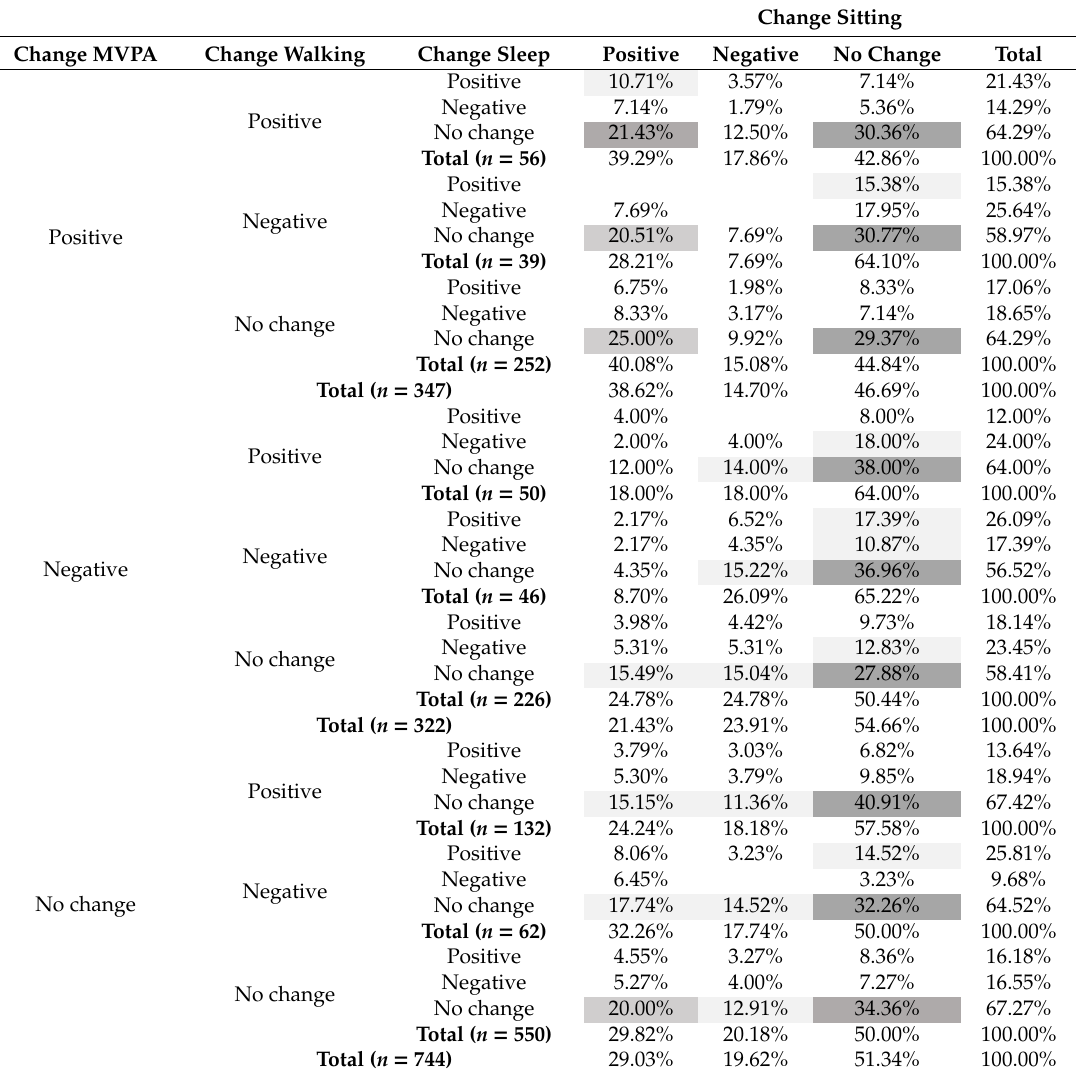
Table 5. Cross-behavioral change from T2 to T3 ( n =